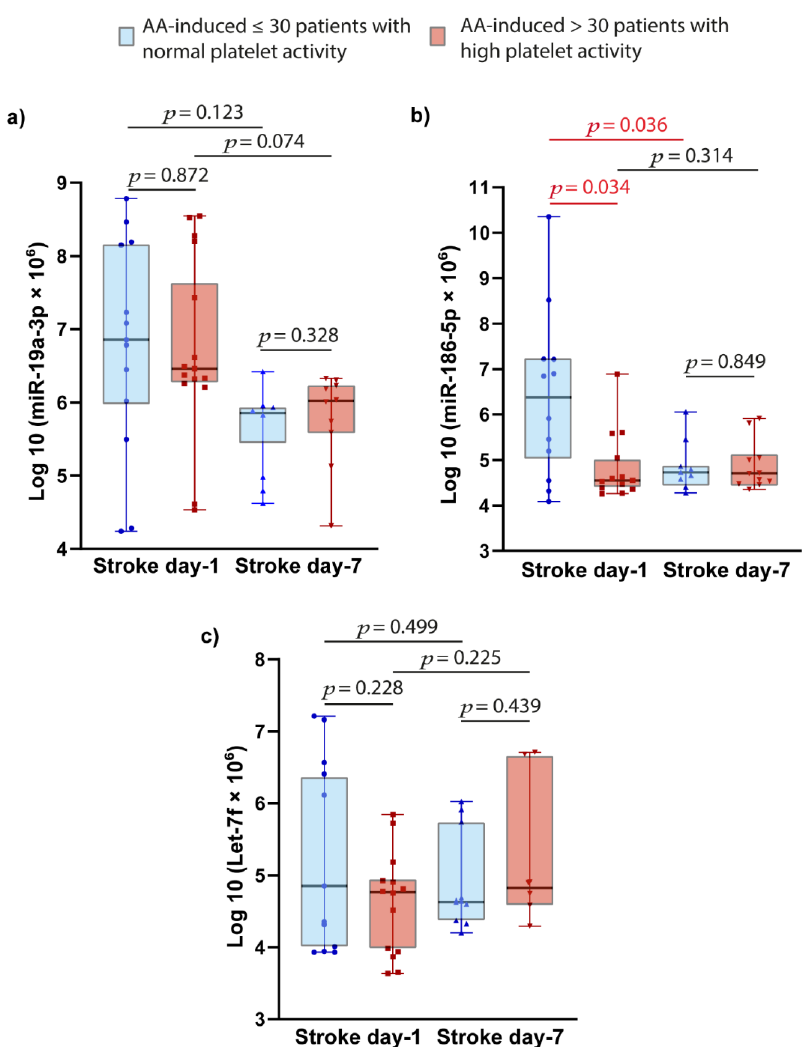
Figure 2. Relation between platelet activation and plasma miRNAs expressions evaluated in